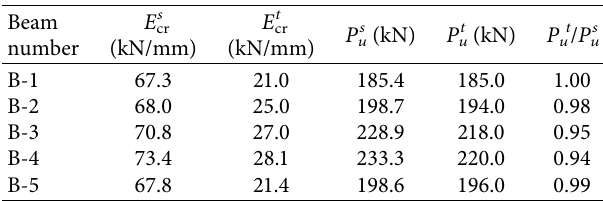
Figure 5: Load-deflection curves of tests and FEA models. (a) B-1. (b) B-2. (c) B-3. (d) B-4. (e) Table 1: Comparison of crack and ultimate loads between sim- ulation and tests.